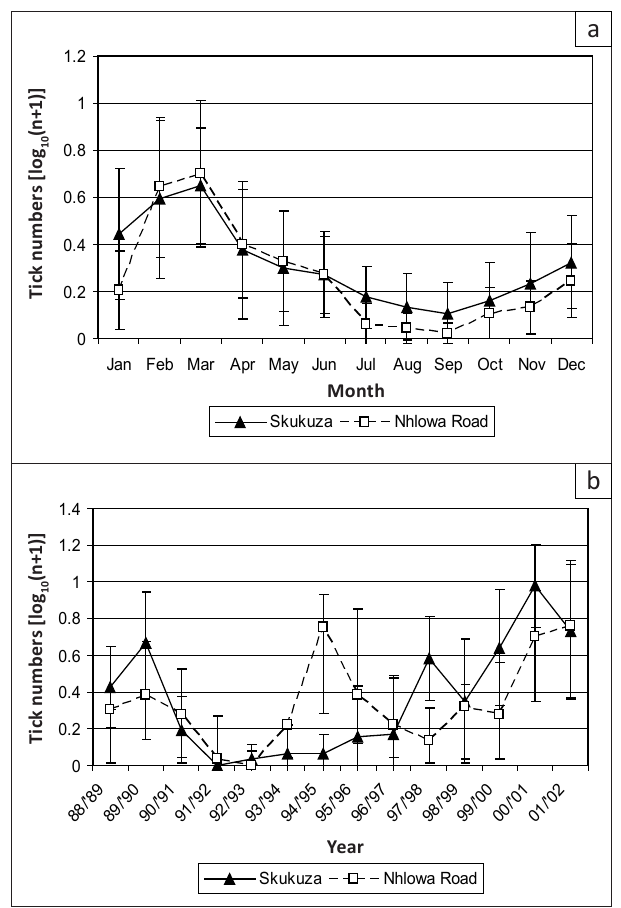
FIGURE 5: Mean collections (± 95% confidence interval) of Rhipicephalus simus adults (a) by month and (b) by year at Nhlowa Road and Skukuza.